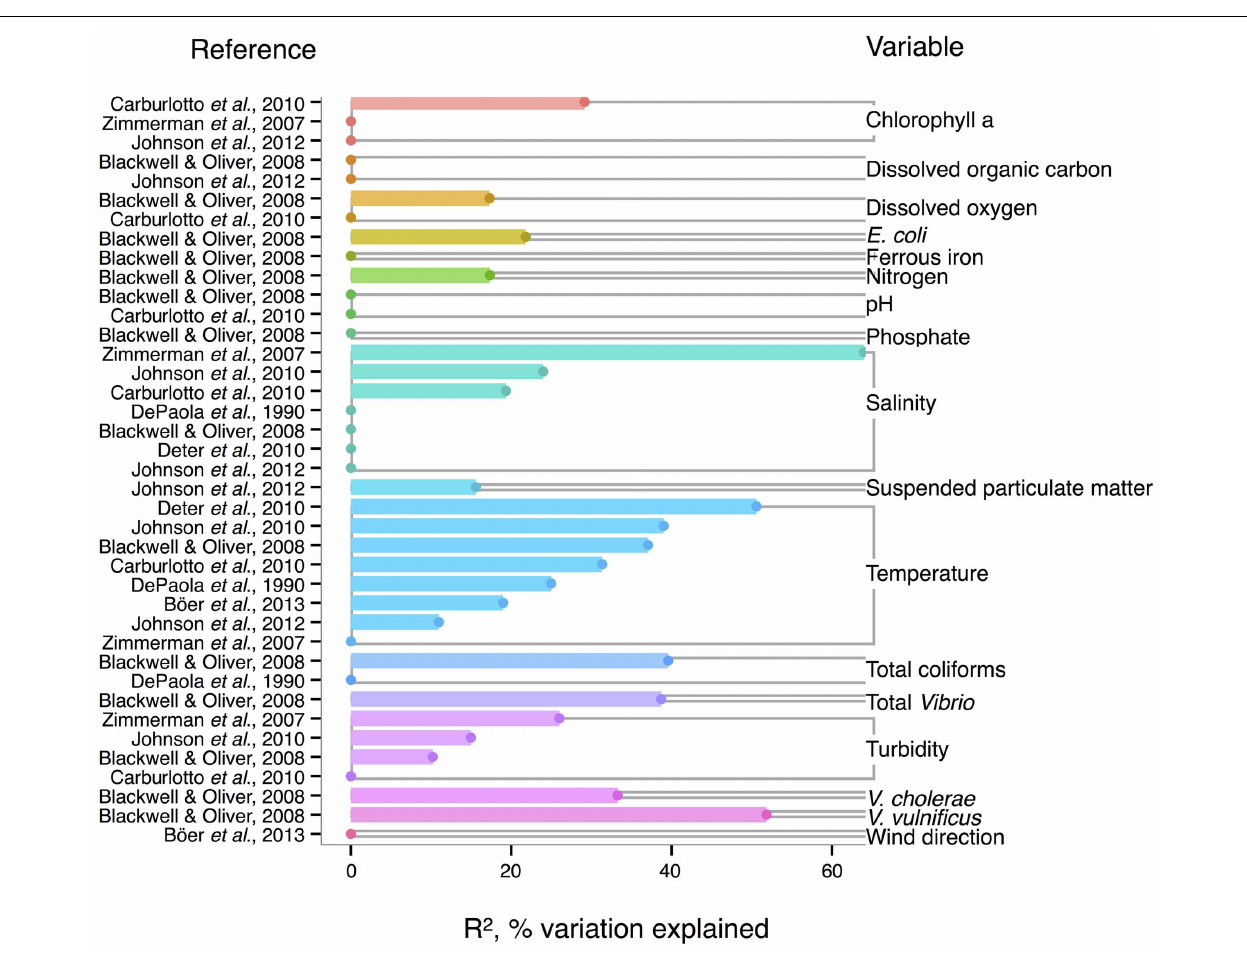
FIGURE 3 | Variation in V. parahaemolyticus abundance or percent positive samples is best explained by temperature and other organisms. R 2 , or pseudo- R 2 , values from analyses across studies are depicted grouped by variable, and then in rank order, with their associated reference. A